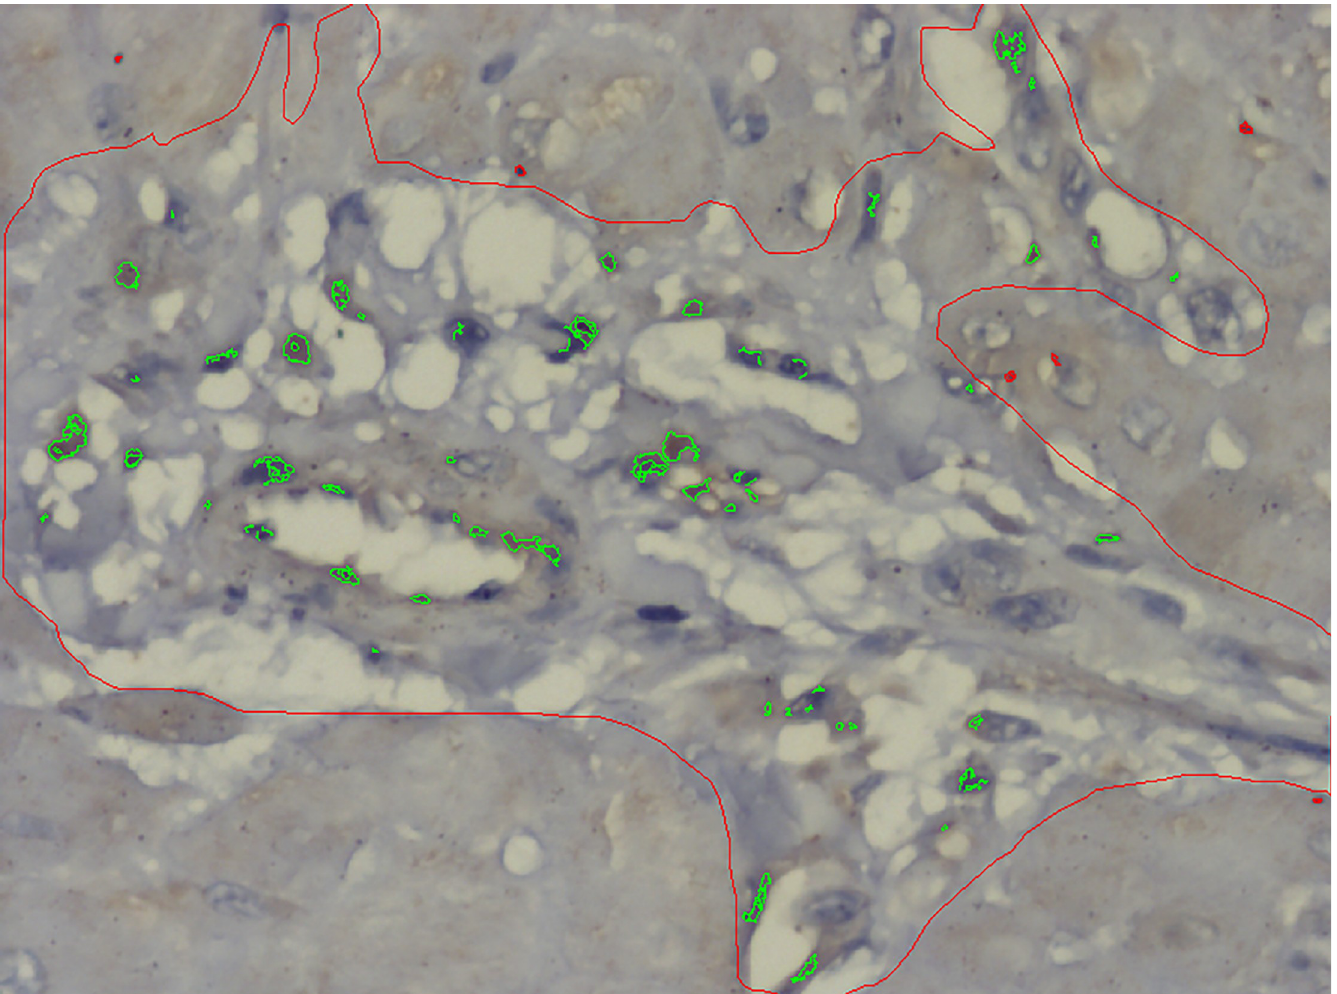
Fig 1. Photomicrograph of the myocardium from an animal of the Intermittent group, counterstained with Harris hematoxylin. The perivascular area is indicated manually (red line). Notice the presence of green spots corresponding to the labeled cells after automatic color detection of VEGF labeling in cells of the vessel walls and perivascular region. Objective magnification = 40X. Image Analyzer: AxioVision, software V.4.7.1.0, Carl Zeiss AG.